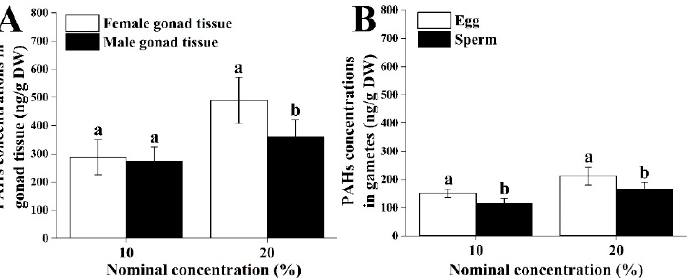
Figure 2. The concentrations of polycyclic aromatic hydrocarbons (PAHs) accumulated in ( A ) gonad tissues and ( B ) gametes from sea urchin females and males exposed to HFO WAFs for seven days. Data were presented as means ± SD. Lowercase letters indicate significant differences between sexes ( p < 0.05). DW stands for dry weight.